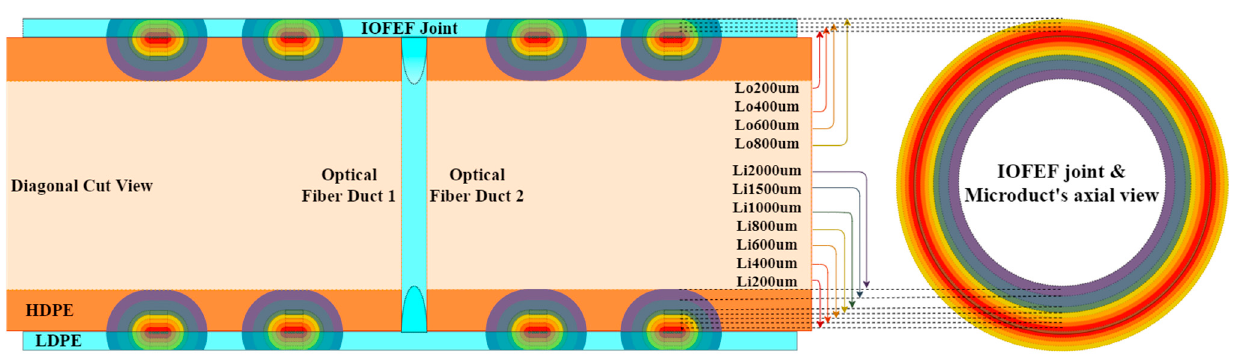
Figure 4. Sketch of inductive-type optical fiber electrofusion (IOFEF) joint with layer distribution used for thermal parameter extraction.